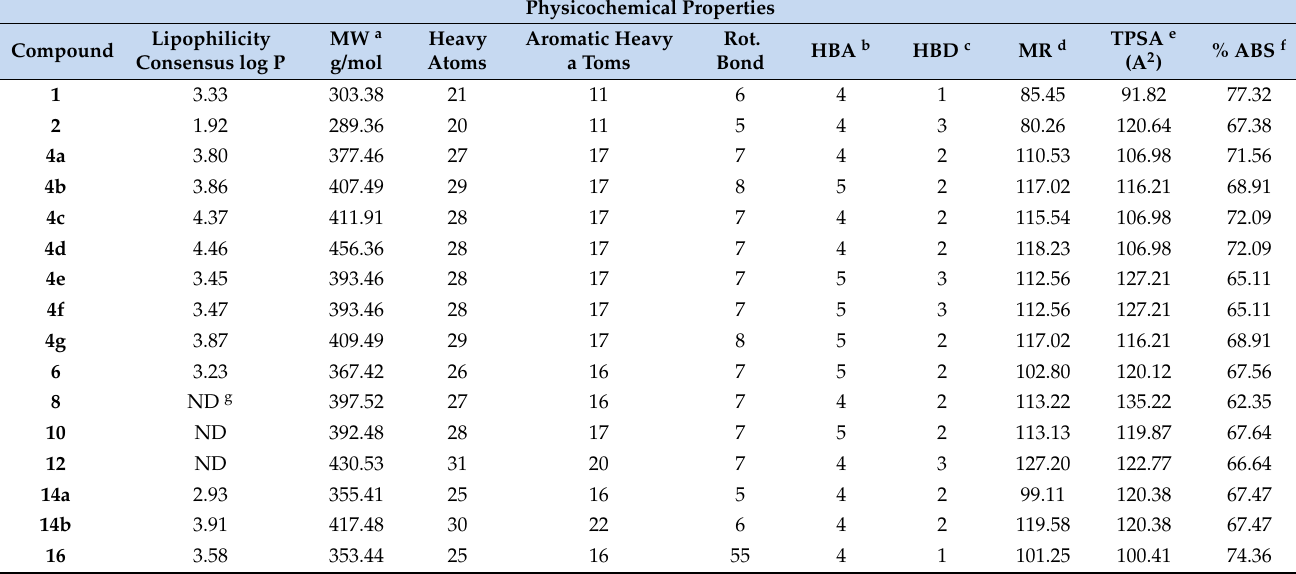
Table 2. Physicochemical properties of the title compounds 1 , 2 , 4a – g , 6 , 8 , 10 , 12 , 14a , 14b , and 16 .